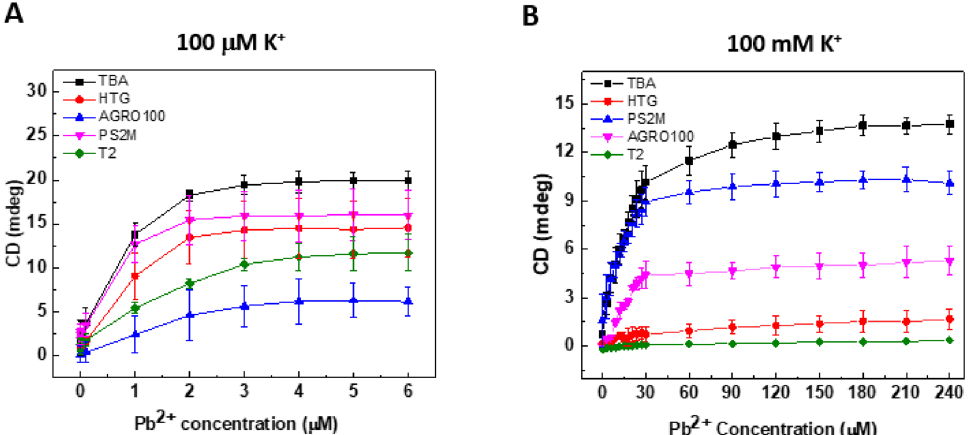
Figure 3. Concentration-dependent CD spectra. ( A ) Pb 2+ -dependent CD response at 100 μM K + concentration. ( B ) Pb 2+ -dependent CD response at 100 mM K +